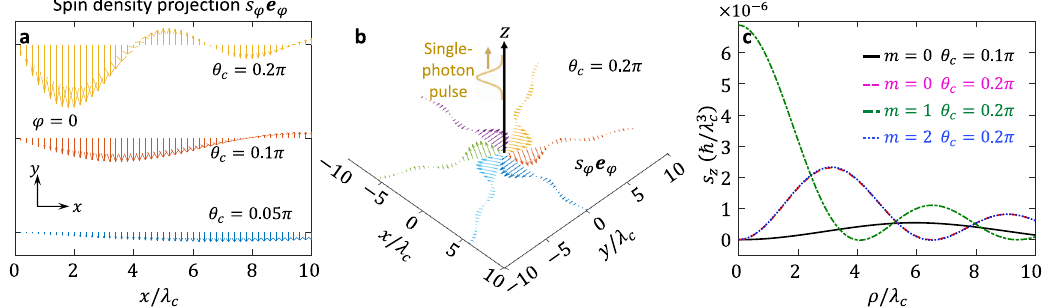
Fig. 5 Details about the spin density vector. Projections of the spin density of a Bessel single-photon pulse on xy -plane (panel a , b ) and on z -axis in panel ( c ). Panel a corresponds to the case with fi xed azimuthal angle ϕ = 0, but different polar angle θ c . Panel b corresponds to the case with fi xed polar angle θ = 0.2 π , but different azimuthal angle ϕ = {0, π /3, 2 π /3, π , 4 π /3, 5 π /3}. Panel c shows the z -component of the c